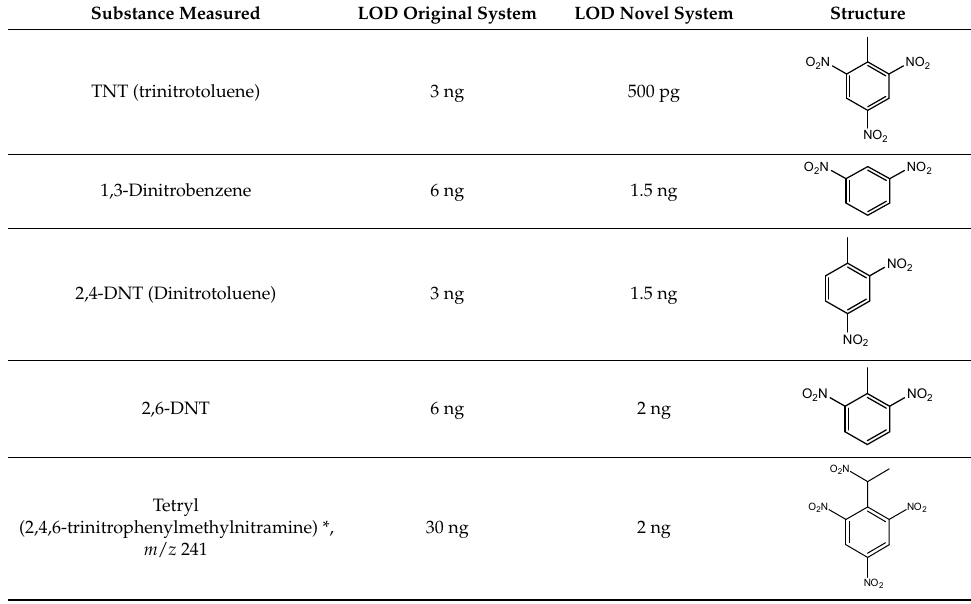
Table 1. Comparison of original and novel APLD systems by use of limit of detection (LOD) for different individually determined explosives. All mentioned improvements were used for the novel APLD system. Old LODs are taken from [31]. Substances that have been detected as fragments are marked with an * and the m / z fragment value. All other substances were detected as molecular ion signals. All substances were measured in negative detection mode.